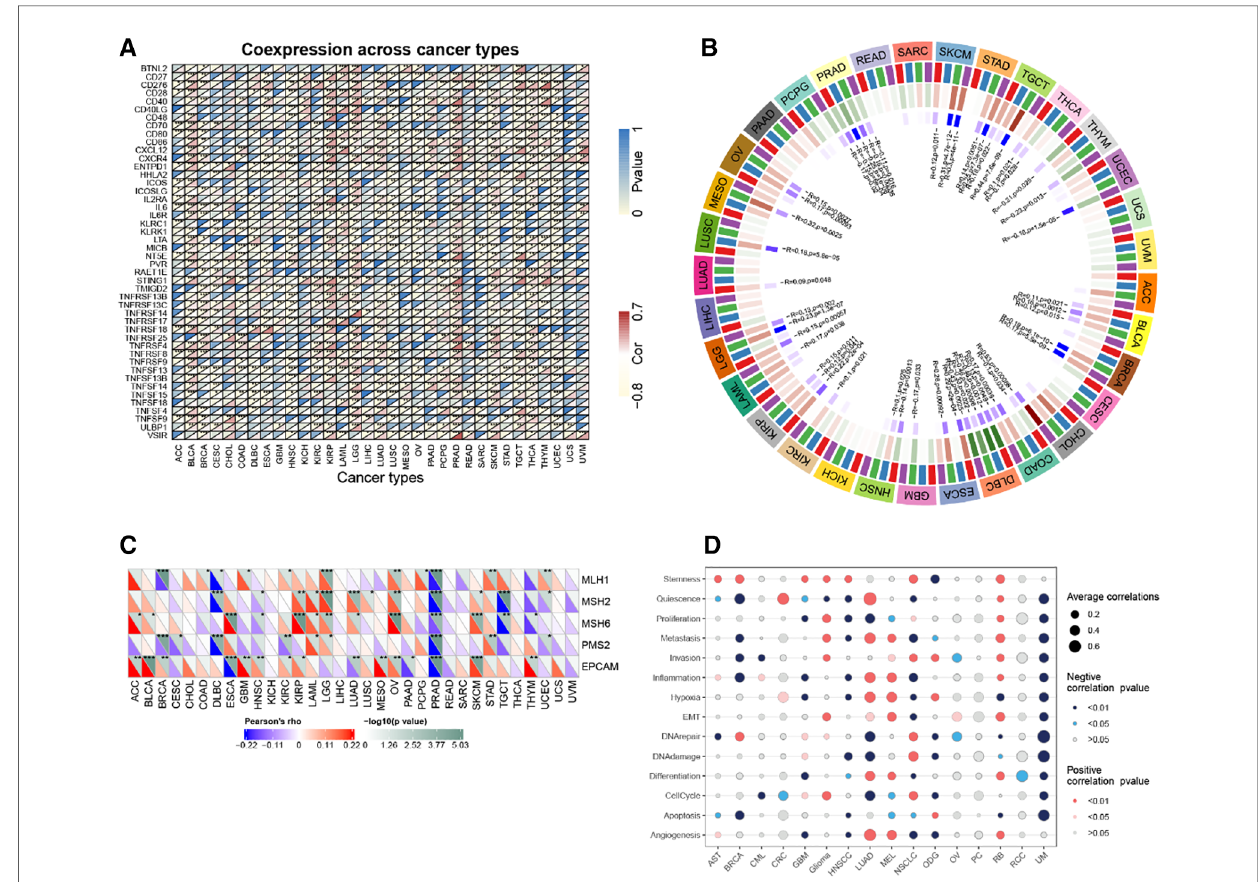
FIGURE 10 Correlation analysis. ( A ) RBP1 expression and immune checkpoint gene correlation analyses. ( B ) DNA methyltransferases and RBP1 expression correlation analysis. ( C ) RBP1 expression and MMR gene correlation analysis. ( D ) The functional status of cancer and RBP1